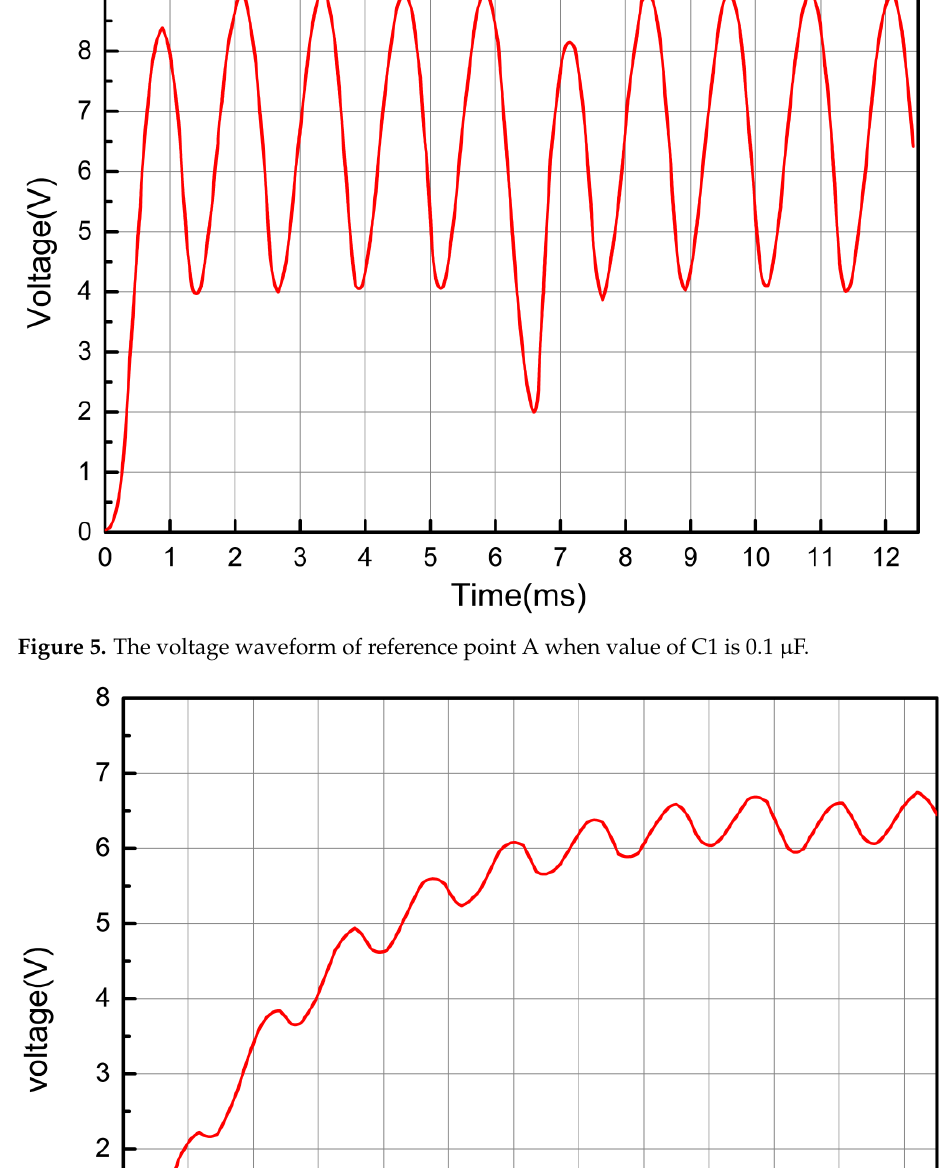
Figure 7. The voltage waveform of reference point A when value of C1 is 2.0 μF . According to the waveform analysis of the analog output results in Figures 5 – 7, it can be concluded that when the value of capacitor C1 is 0.9 μF, the output voltage waveform of referenc e point A is more stable, so the value of C1 is selected as 0.9 μF .